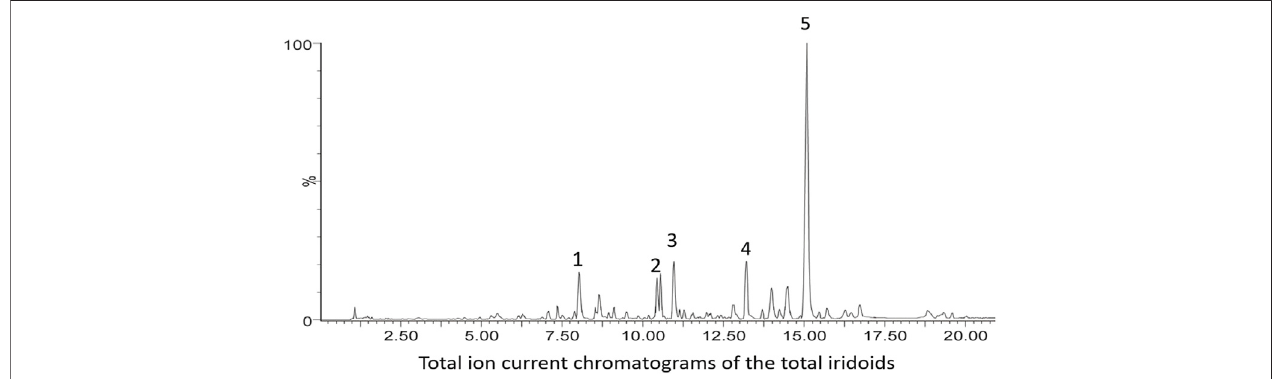
FIGURE 2 | Quantitative analysis of GJ-IF. The UPLC chromatograms of GJ-IF are shown in Figure 2 . The full MS and full MS/MS2 modes were generally used to capture all target ion information between MS1 and MS1,2 for qualitative analysis comparison. The major compounds in GJ-IF were identi fi ed to be geniposide, respectively.